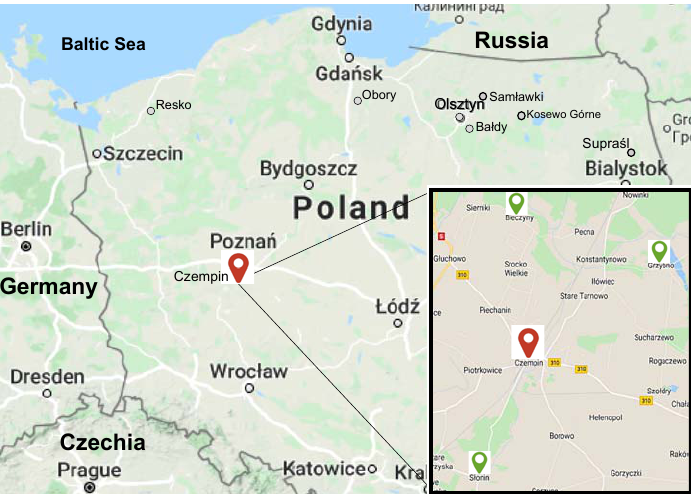
Figure 1. The location of foraging plots. The exact geographic coordinates are given in the text.